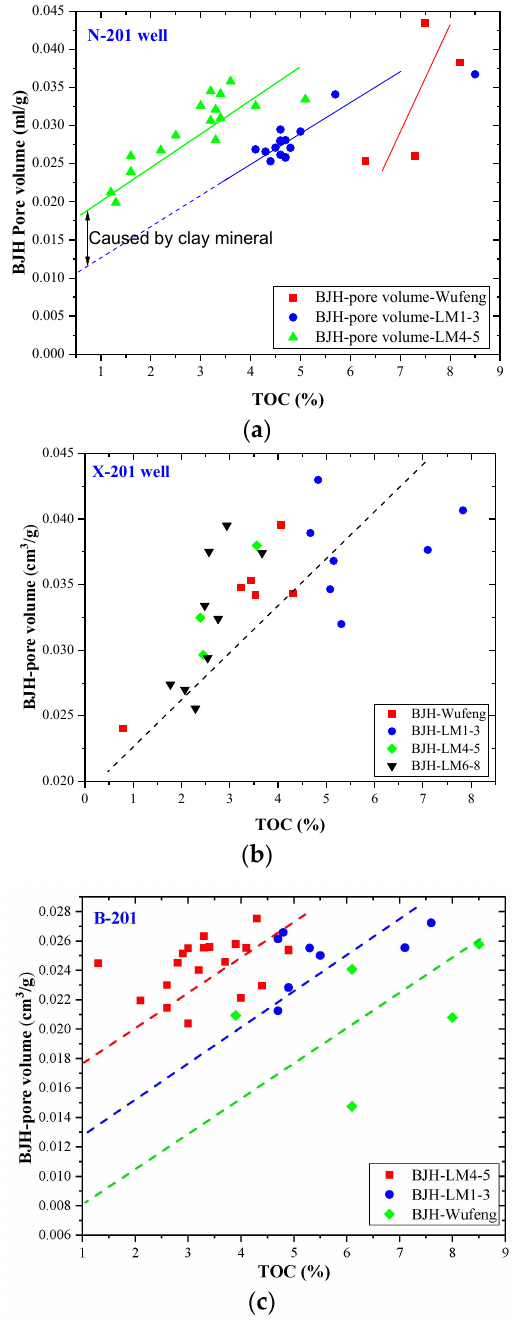
Figure 11. The correlations between BJH pore volume and TOC content of the shale samples from ( a ) the N201 well, ( b ) the X201 well, and ( c ) the B-201 well. By comparing Figures 10b and 11b, it can be seen that in all the samples for the X201 well, the BET surface area and the BJH pore volume both increase with increasing TOC content. The shales of different substrata in X201 well have similar pore size distributions. This is different from the N201 well. The relationship between BJH pore volume and TOC content in well B201 is more complex (Figure 11c). Although the BET surface increases with increasing TOC content, the overall correlation between BJH pore volume and TOC is quite weak. By analyzing the different substrata separately, the BJH pore volume also increases with increasing TOC content. That means small nanopores were provided by OM and there are many large inorganic pores in shale from the B201